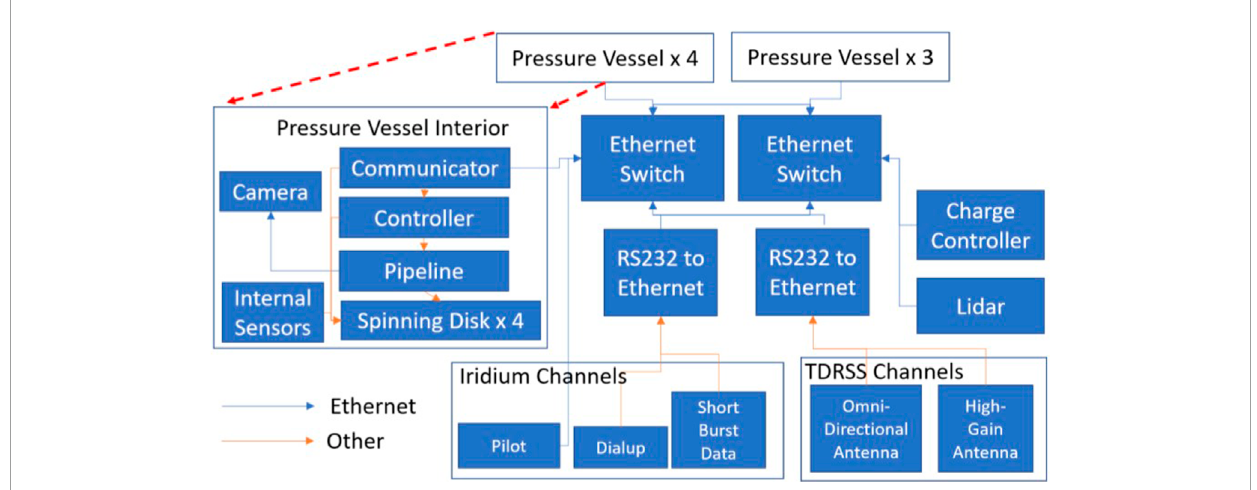
FIGURE 1 An overview of the PMC-Turbo network. The instrument suites within the pressure vessels, charge controllers, lidar, and telemetry antenna primary communicate over a local ethernet network. The expanded box labelled “Pressure Vessel Interior” shows the communication links between the subsystems associated with each computer. Figure originally published in Kjellstrand et al. (2020).